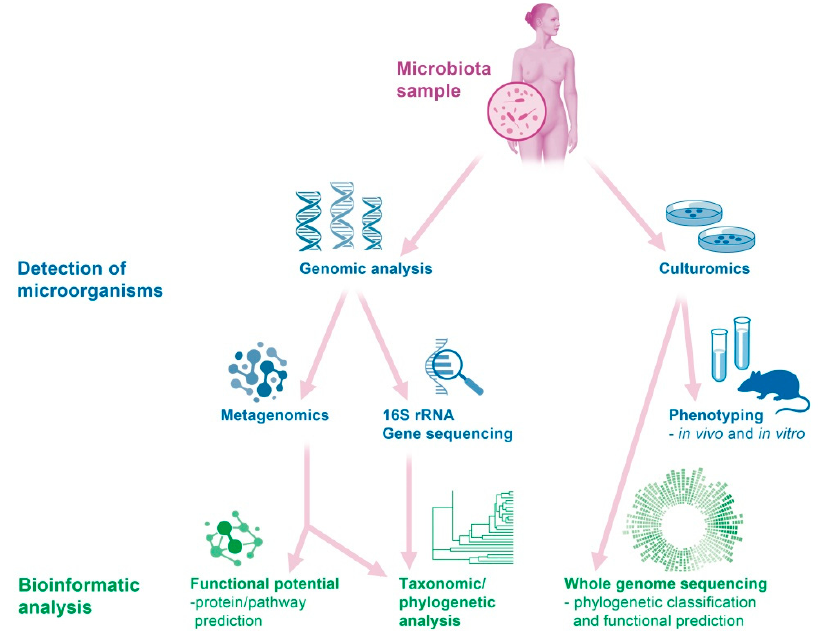
Figure 2. Overview of some of the most common techniques used to analyze the vaginal micro-